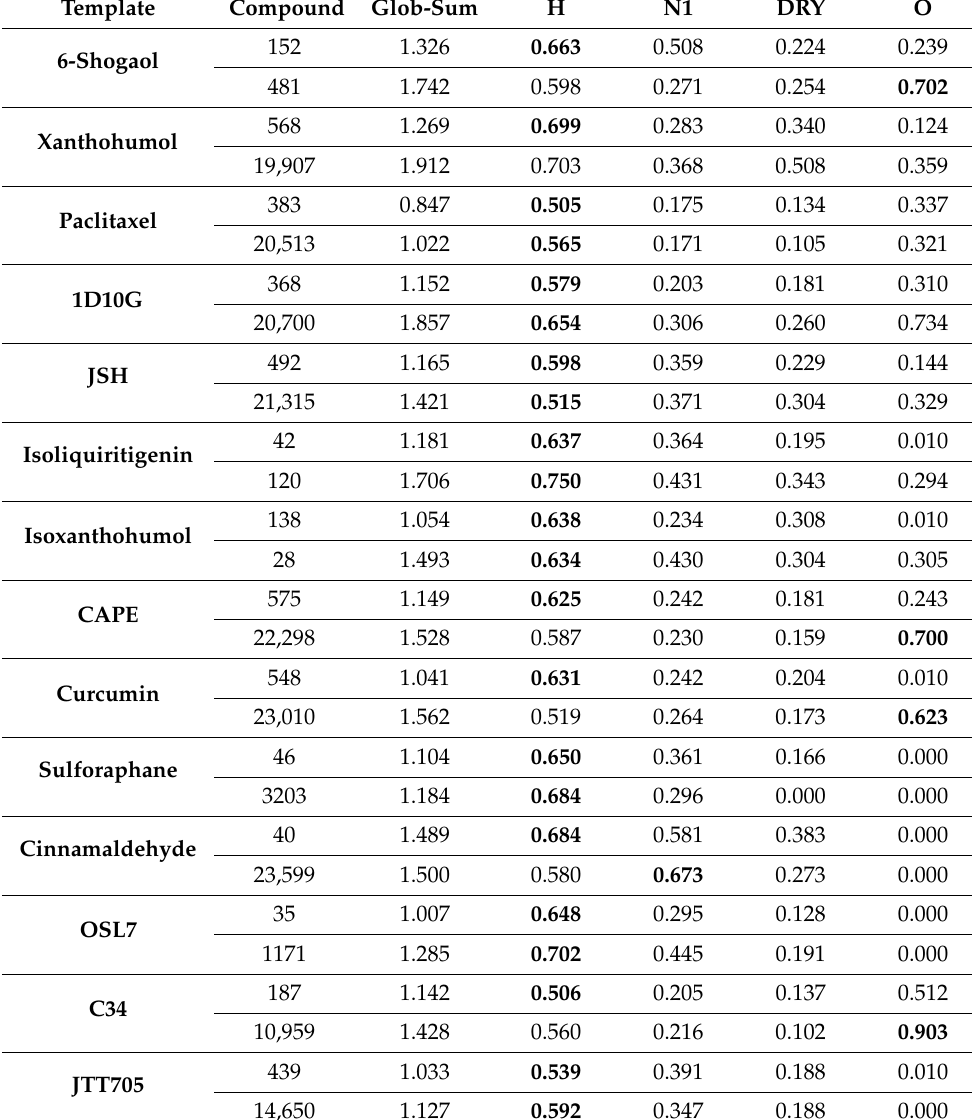
Table 2. Best-ranked compounds from LBVS of the Log P 1000 (blue) and SPECS (white) sets for each template (reported MD-2 ligands). The Glob-Sum score is a global similarity score calculated by summing the four single contributions: shape (H), hydrogen bond acceptor (N1), hydrophobic (DRY), and hydrogen donor acceptor (O)